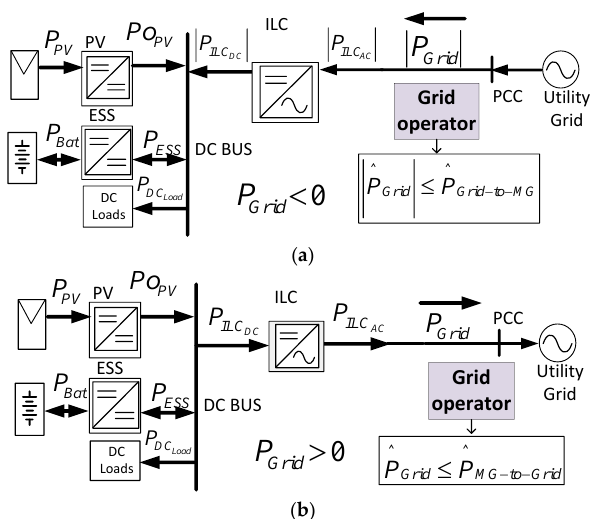
Figure 6. The power flow scenarios between the grid and the DC microgrid: ( a ) Power flow from the grid to the DC microgrid ( P Grid < 0); ( b ) Power flow from the DC microgrid to the grid ( P Grid > 0).